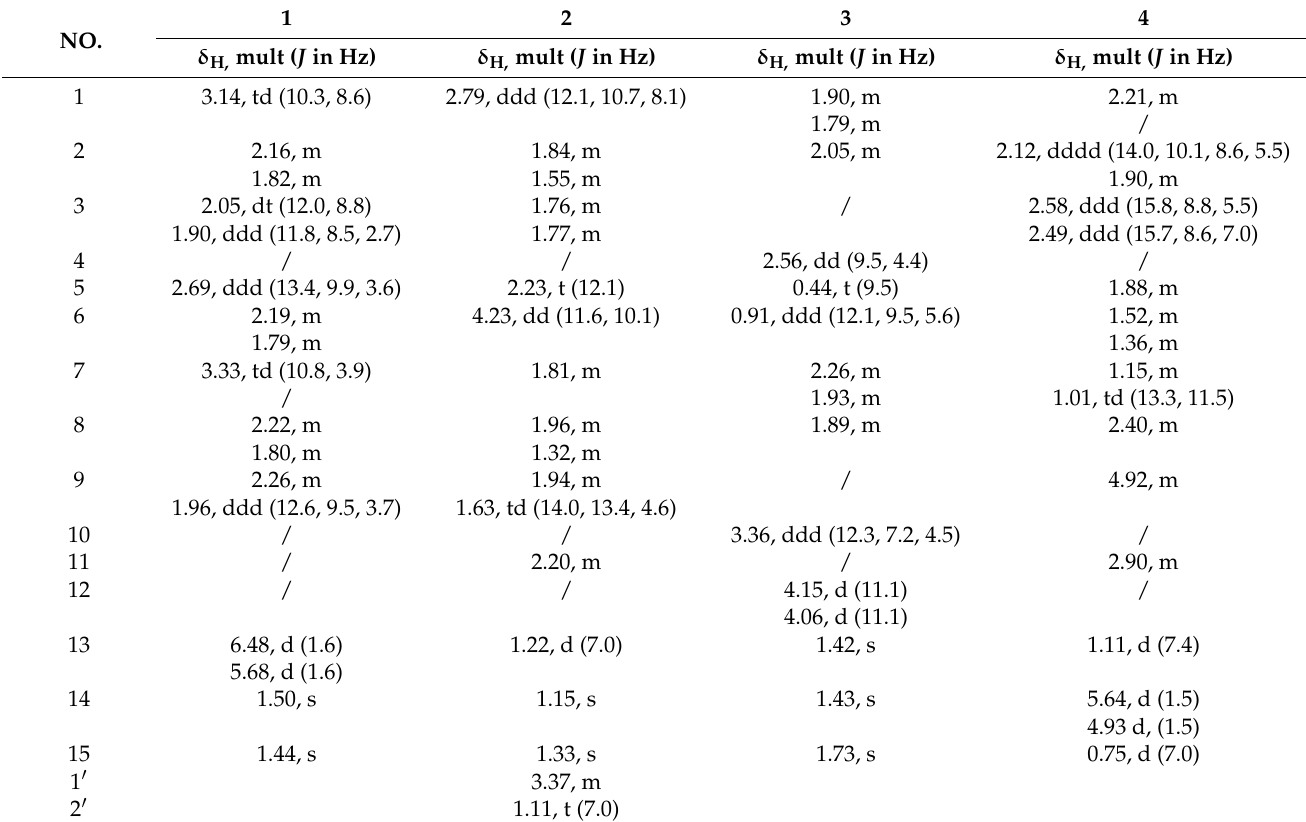
Table 1. 1 H NMR spectrum (600 MHz) data of compounds 1 – 4 .